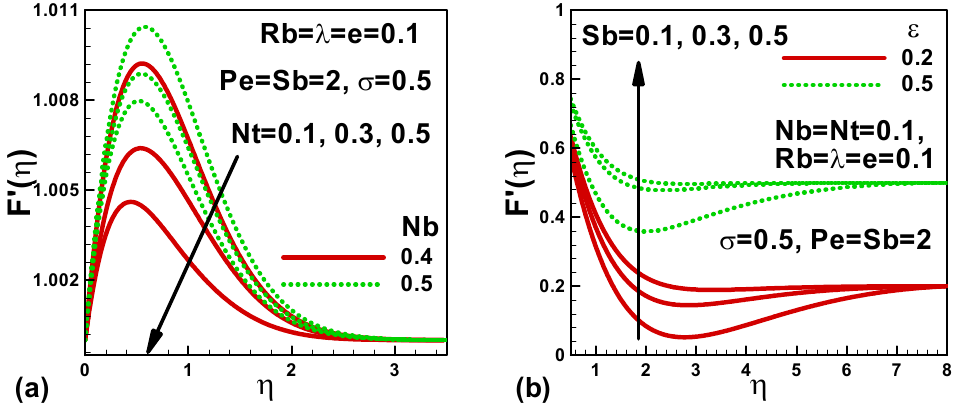
Figure 3. Variation of dimensionless velocity with ( a ) nanofluid parameters and ( b ) bioconvection Schmidt number.